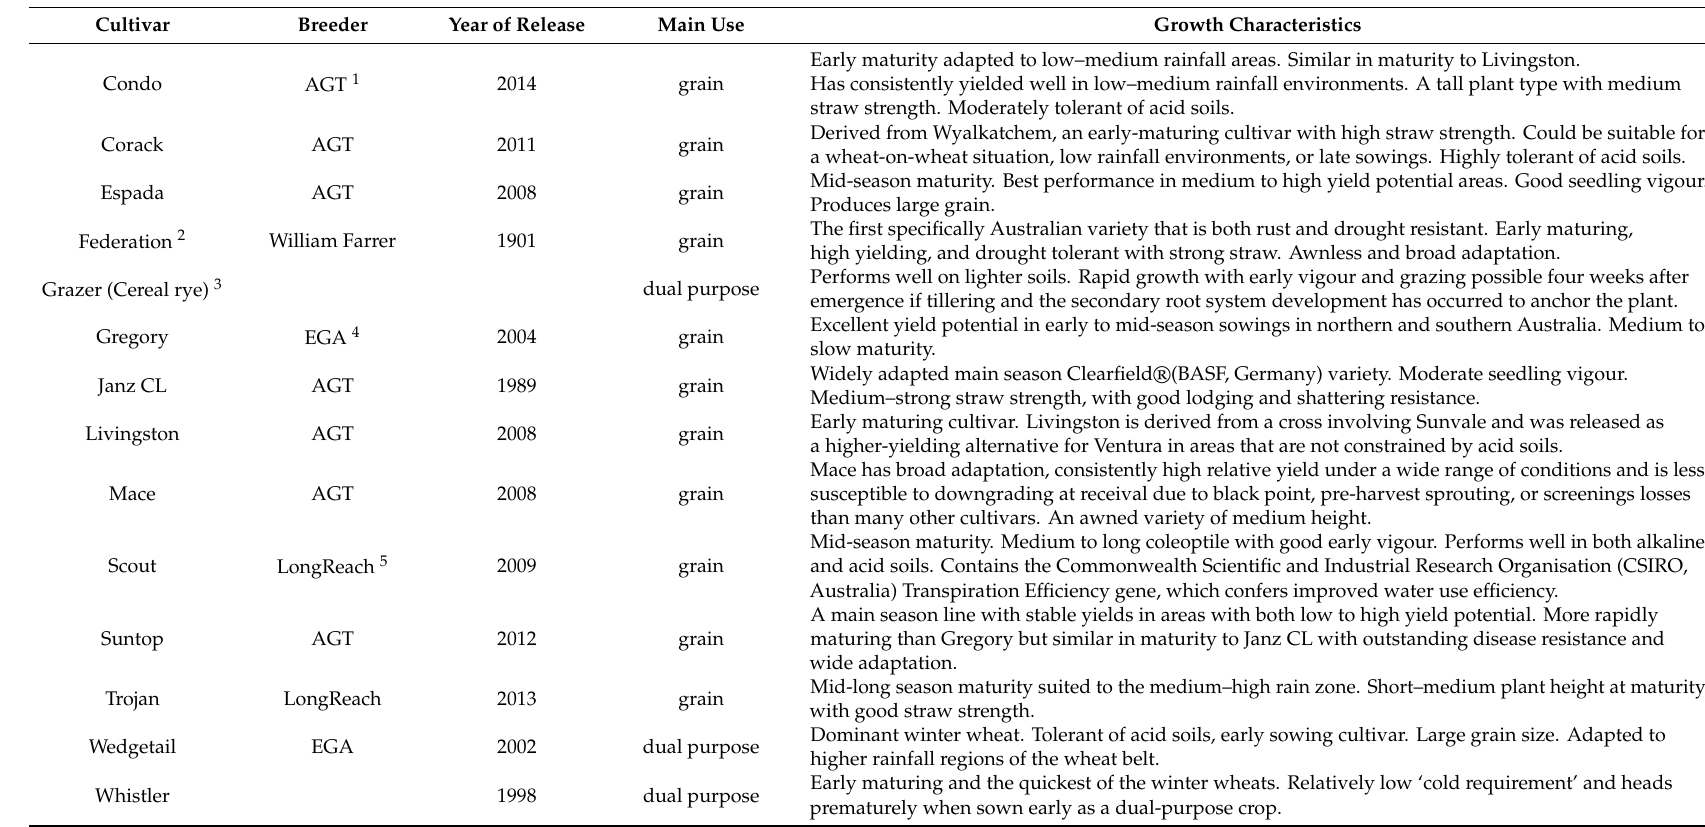
Table 1. Wheat cultivars and commercial use for field trials performed in Condobolin and Wagga Wagga, NSW in 2015 and 2016.